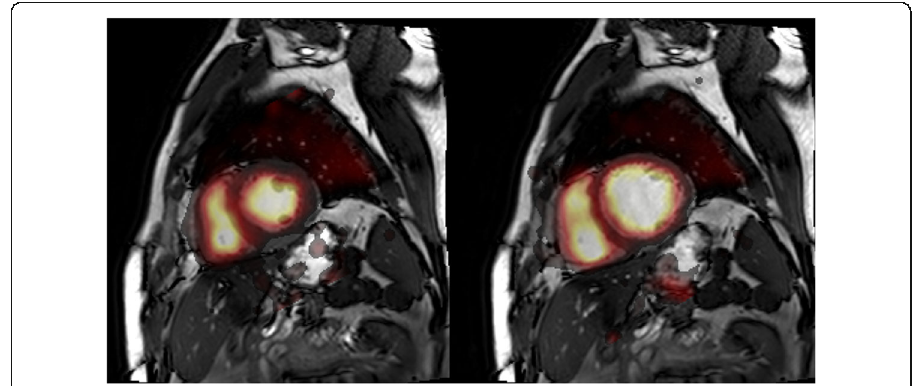
Fig. 2 End-diastolic (left) and end-systolic (right) fusion between parametric 15 O-water blood volume ( V B ) and MRI images